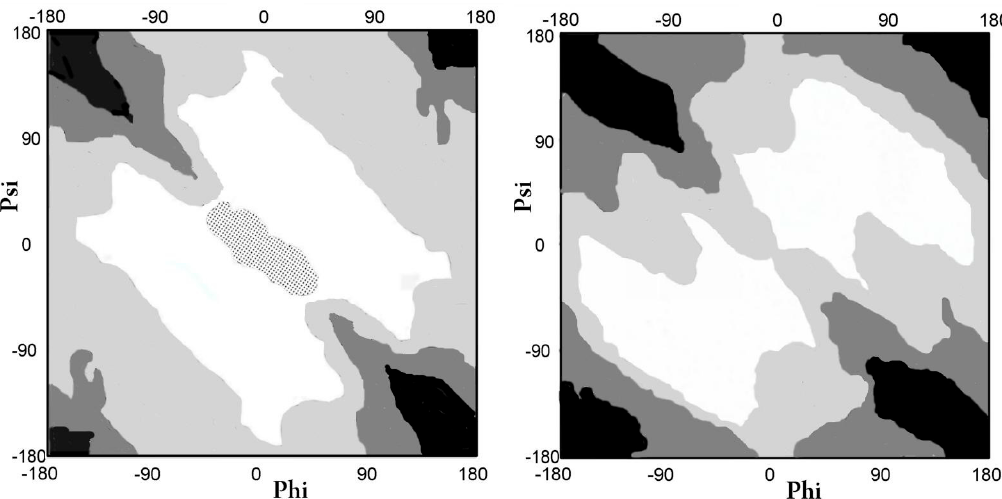
Figure 7. Map of Phi, Psi with marked value levels; ( A ) curvature radius; ( B ) the V angle; the gradation of color shows the increase in the value of the parameter. The area marked as black on map A—radius of curvature ln(R) > 5, black area for map B–V angle > 150 deg.; white area for map A—radius of curvature ln(R) < 2, white area for map B–V angle < 10 deg.; area covered with dots on map A—area not discussed. Int. J. Mol. Sci. 2019 , 20 , x FOR PEER REVIEW